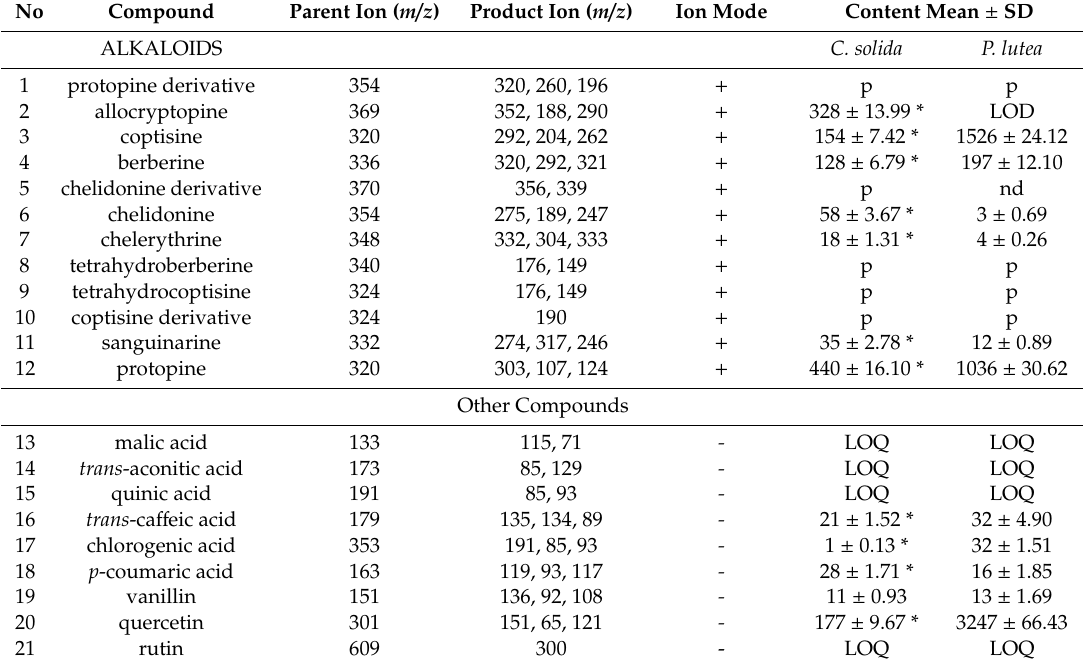
Table 1. The content ( µ g / g d.w. ± SD) of quantitated compounds in aerial parts of C. solida and P.